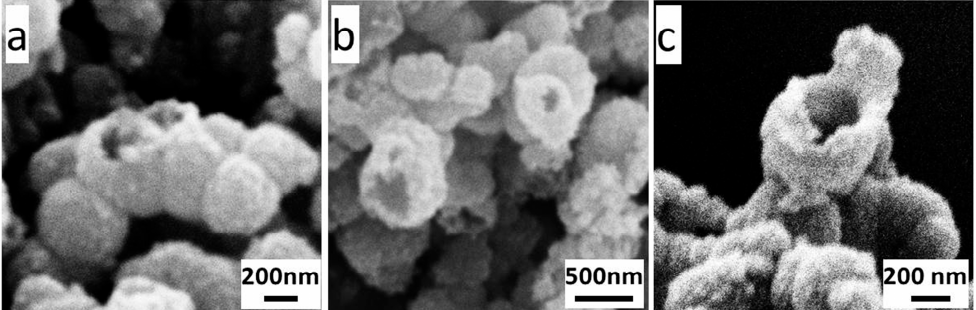
Figure 8. SEM local magnification images of macroporous Fe 3 O 4 microparticles F 0.0525 : dumbbell-like or bead-like hollow microspheres ( a ); expanding holes ( b ); and typical open-cell hollow microsphere ( c ).